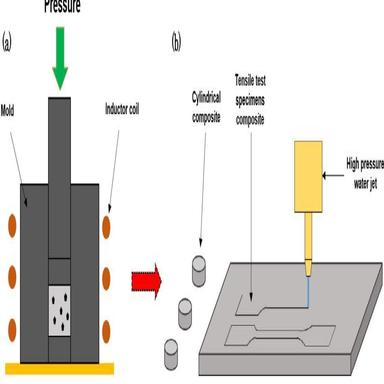
(a) Schematic hot-pressing method by induction heating and uniaxial compressive stress of solid-state sintered Al/B4C composites, (b) Two geometry of samples have been fabricated: cylindrical form for thermal characterization and ingot were machined by a high-pressure water jet for tensile test specimens.